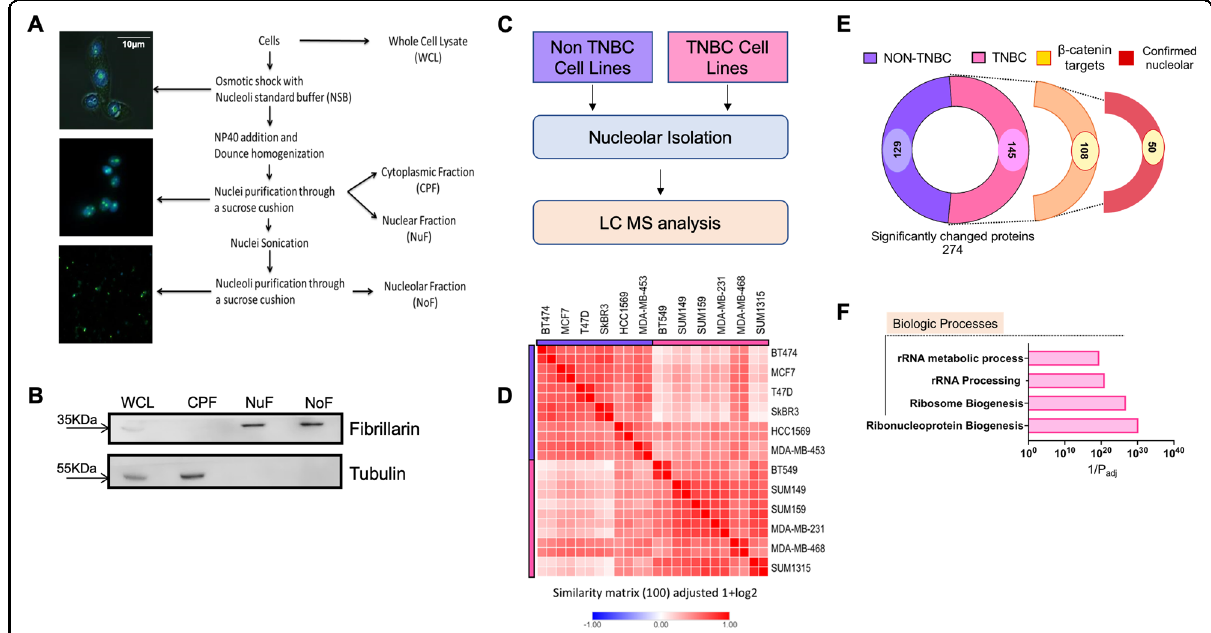
Fig. 2 Identi fi cation of differences in nucleolar proteomes of TNBC and non-TNBC cells. A Graphical representation of the steps involved in isolating nucleoli from breast cancer cells. B Representative immunoblot showing veri fi cation of enrichment of nucleolar proteins. Fibrillarin is used as an indicator of nucleolar proteins. The absence of tubulin from the nuclear and nucleolar fractions was monitored to ensure purity. C Schematic summarizing work fl ow for nucleolar isolation and proteomic analysis to identify signi fi cantly altered proteins in the nucleolus between TNBC and non-TNBC cell lines. D Similarity matrix comparing nucleolar proteomes of TNBC cell lines with that of Non-TNBC cell lines. The proteomes were determined from two biological replicates. The matrix shows proteomes from both replicates of each cell line. E Graphical break-down of signi fi cantly altered proteins found in the nucleolar proteomics of the TNBC groups. Out of 145 proteins enriched in TNBC nucleoli, 108 were potential transcriptional targets of β -catenin. Out of these, 50 proteins were already reported to be nucleolar in one or more previously reported nucleolar proteomes from studies conducted in other (not breast cancer) cell types 8,28,29 . F Gene ontology analysis of proteins enriched in the nucleolar proteome of TNBC compared to Non-TNBC for biologic processes. The analysis was performed using g:Pro fi ler ™ 30